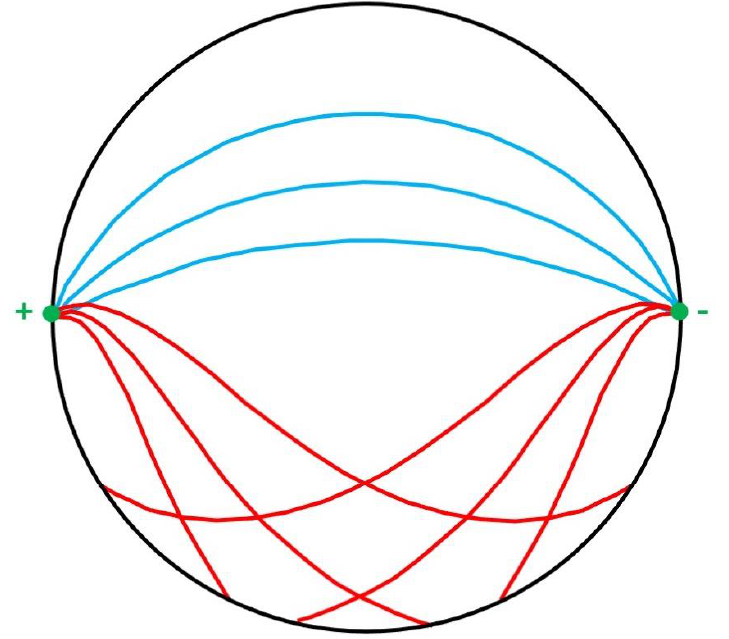
Figure 7. The trajectories of copper and sulfate ions in water. The magnetic field is directed out of the paper. Blue: calculated using realistic ion mobilities (the trajectories are almost the same as those when the magnetic field is zero). Red: calculated using Truong et al.’s ion mobilities [19]. Adapted from Figures 1 and 2 in [20].